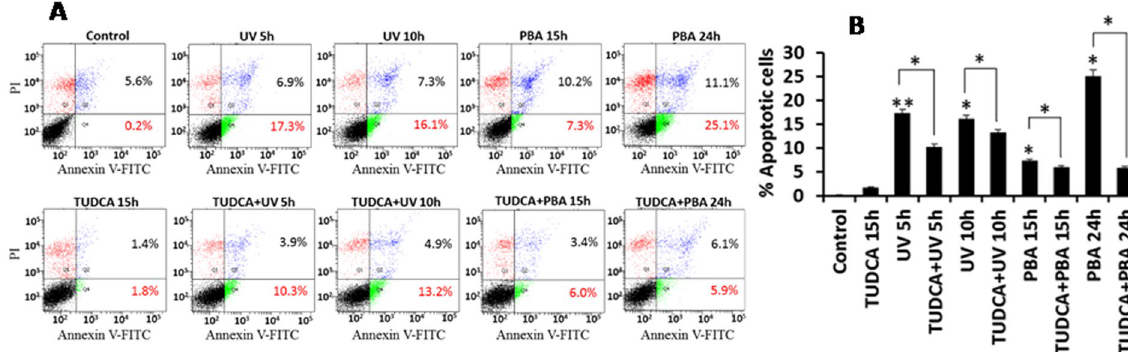
Figure 8. TUDCA inhibits UV-B irradiation and PBA induced apoptosis: TUDCA (2 mM) pretreated HepG2 cells were treated with UV-B irradiation for 60 seconds and incubated at 37° C for 5 and 10 h or with 5 mM PBA for 15 and 24 h. Apoptosis was measured with annexin V-FITC/PI staining by FACS analysis as suggested by manufacturer. Lower right quadrant (Q4) represents early apoptosis, that is, Annexin V-FITC-positive/ PI-negative cells; upper right quadrant (Q2) represents necrosis or late-apoptosis, that is, Annexin V-FITC- positive/PI-positive cells. Panel B bar diagram represents per cent of cells undergoing apoptosis as shown in panel A. Data shown are mean ± SD of three independent experiments. * P < 0.05, ** P < 0.01. P value is calculated by